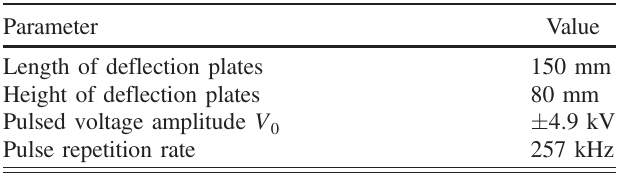
TABLE II. Main parameters of the electric deflection unit.